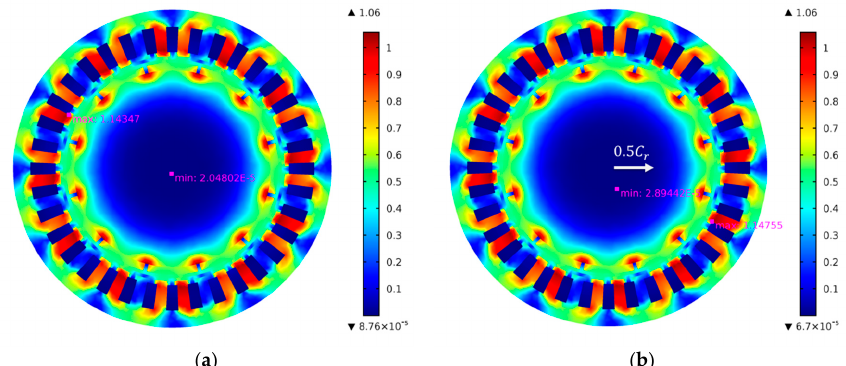
Figure 5. Flux density of the motor at 0.02 s with different eccentricities. ( a ) 0% eccentricity; ( b ) 50% eccentricity.